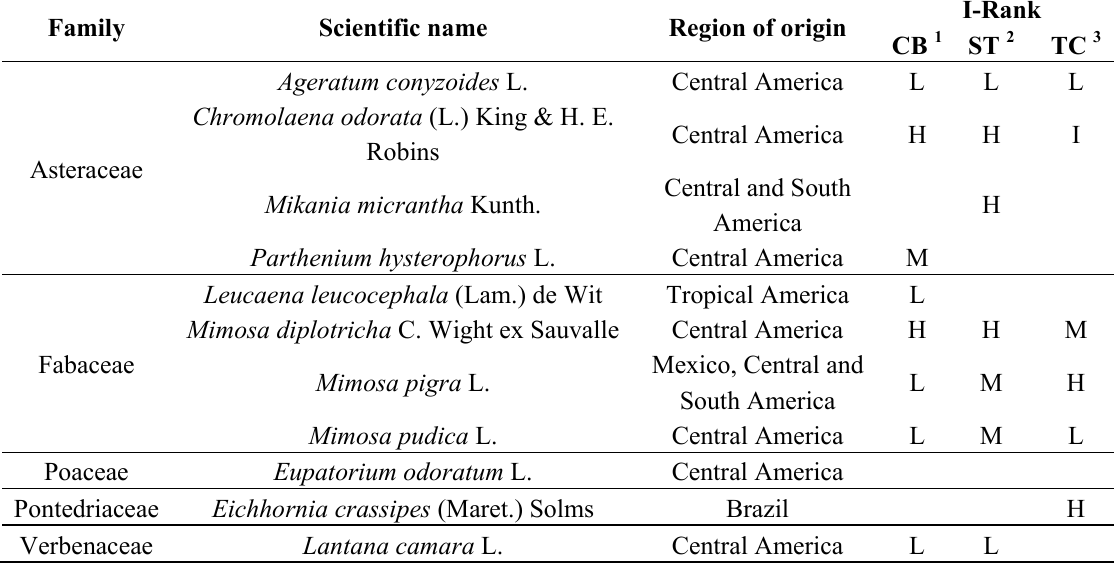
Table 2. The risk (I-Rank) of invasive alien plant species at three parks The risks were categorized into four classes, High (H), Medium (M), Low (L) and Insignificant (I).